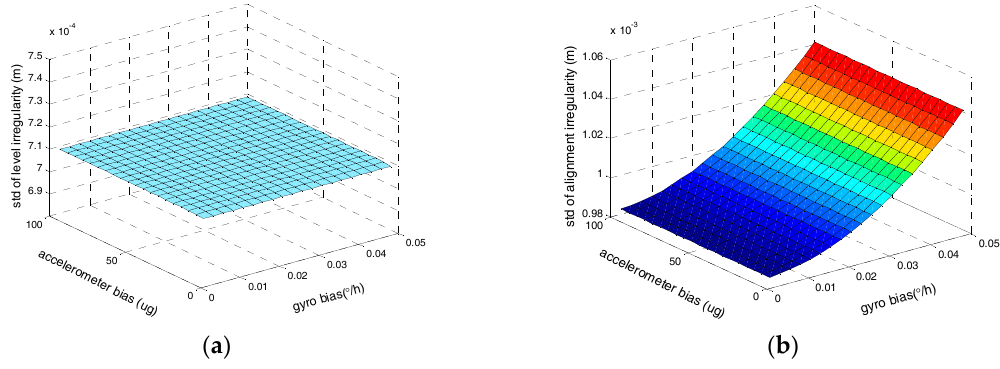
Figure 11. ( a ) The relationship between level irregularity measurement accuracy and the biases of inertial sensors; ( b ) The relationship between alignment irregularity measurement accuracy and the biases of inertial sensors.